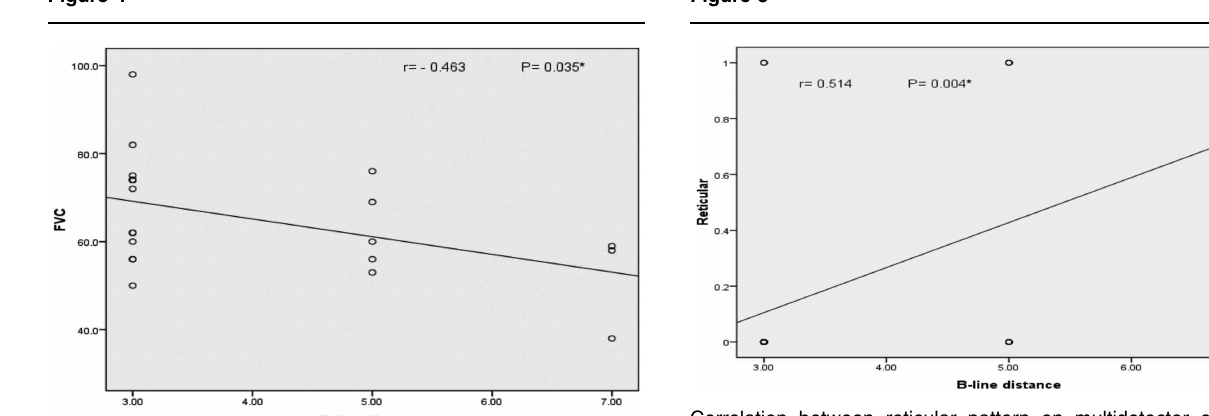
Correlation between reticular pattern on multidetector computed tomography (MDCT) and B-line distance in patients with interstitial lung disease (ILD).